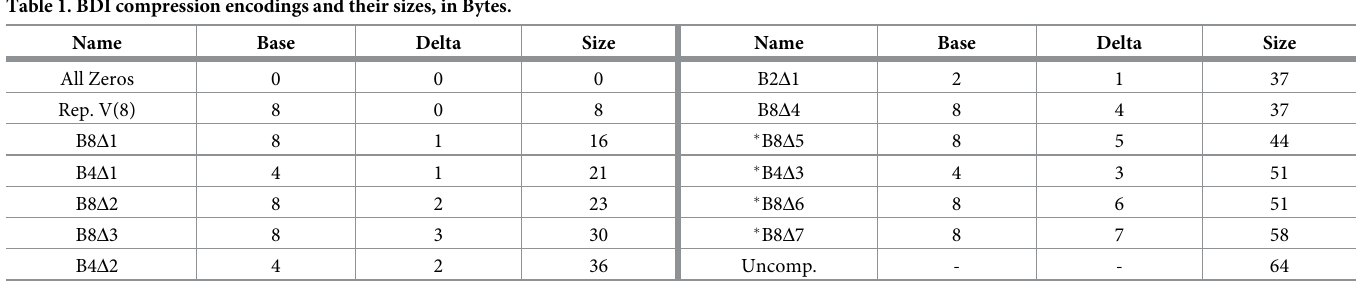
Table 1. BDI compression encodings and their sizes, in Bytes.